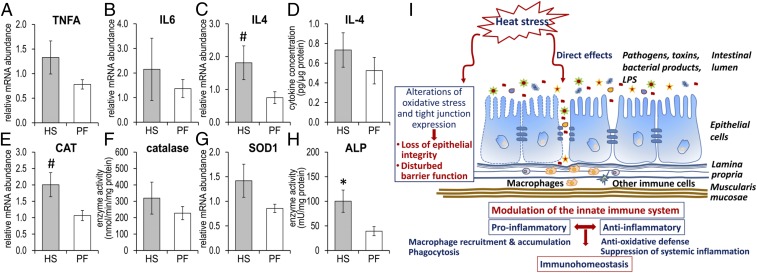
Higher IL4 and CAT gene abundance and ALP activitiy in mucosa after long-term heat stress. RT-qPCR analysis of the mRNA expression of (A) TNFA, (B) IL6, (C) IL4, and (D) IL4 protein after 4 d of heat stress or pair feeding. (E) mRNA analysis of CAT and (F) catalase enzyme activity, (G) mRNA expression of SOD1, and (H) ALP activity in jejunal mucosa of HS and PF cows. n = 5 (means ± SEM). *P < 0.05 and #0.05 < P < 0.1. (I) Model of direct long-term heat-stress effects on the jejunal mucosa in lactating dairy cows.